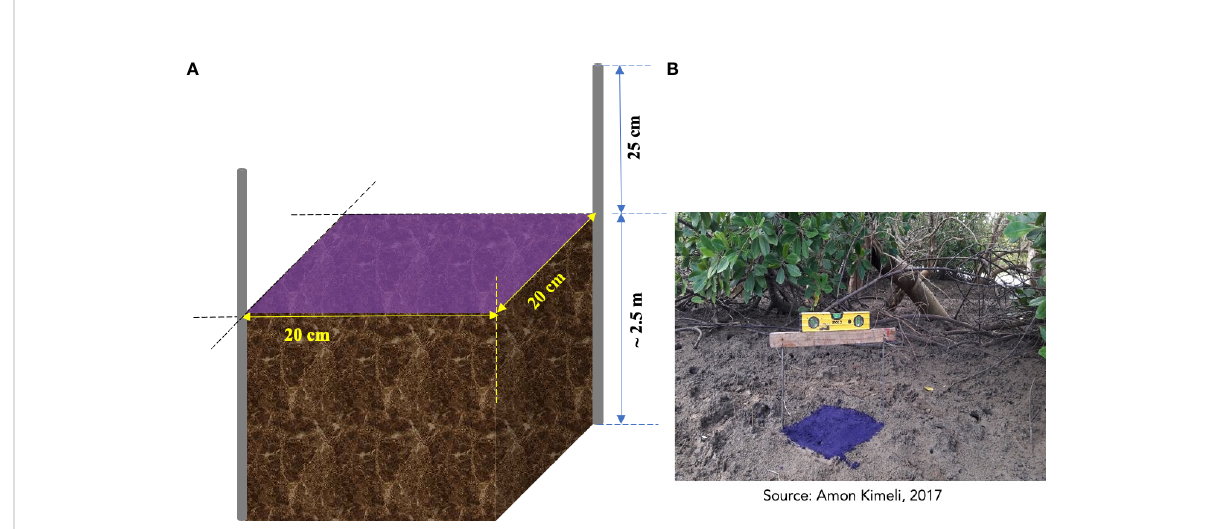
FIGURE 4 (A) Conceptual illustration (not to scale) of the surface-elevation table and horizon marker and (B) the actual fi eld set up (right) within Vanga mangrove forest, Kenya. Elevation changes were measured along the wooden board levelled using a spirit level, and surface accretion changes were measured based on the accreted sediments above the purple crystal violet horizon marker (see panel B